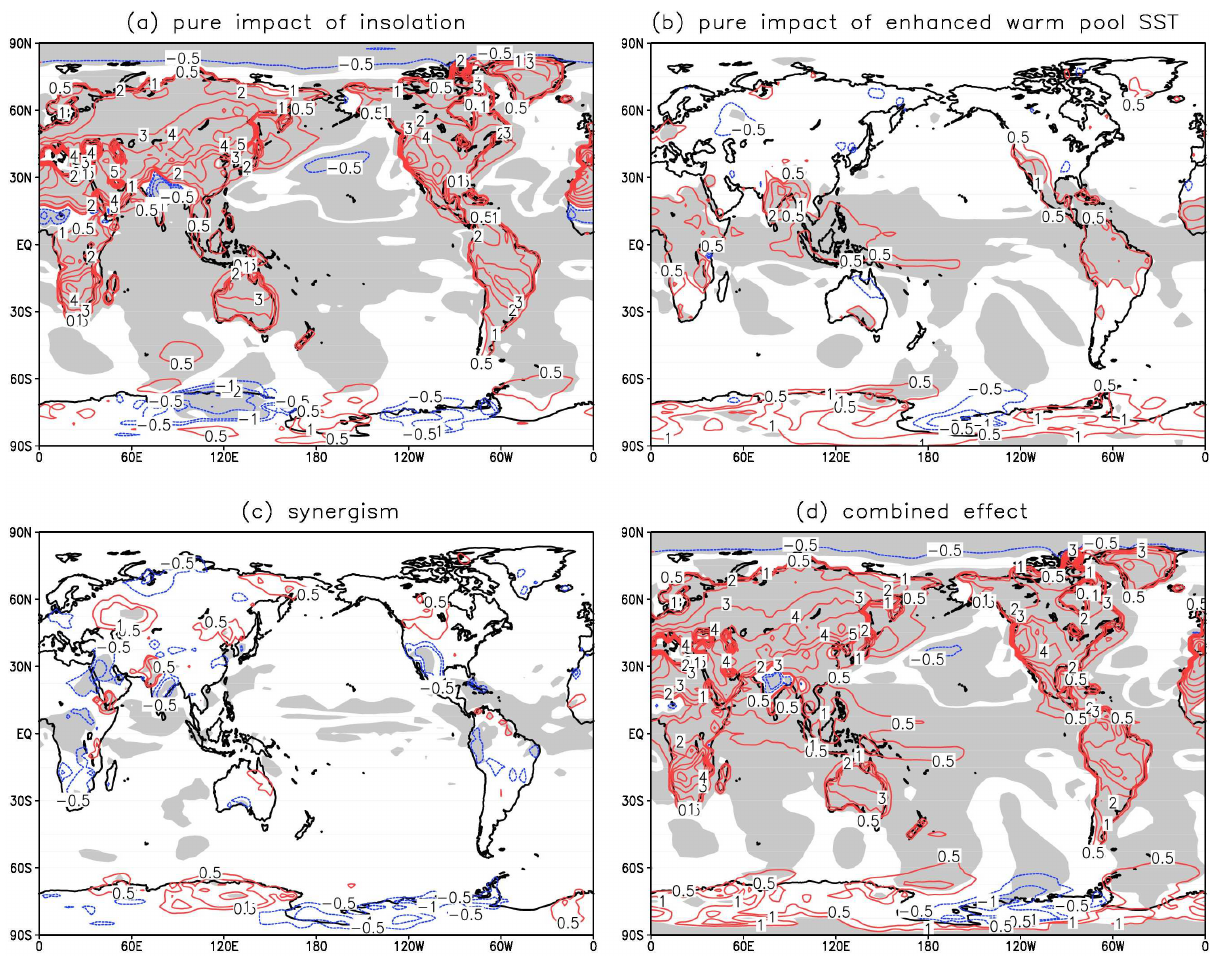
Figure 2. Simulated summer (JJA) surface air temperature anomaly ( ◦ C). (a) Pure impact of insolation, (b) pure impact of enhanced IPWP SST, (c) synergism between insolation and enhanced IPWP SST and (d) combined effect of insolation and enhanced IPWP SST. Areas with significance level greater than 99% are shaded in